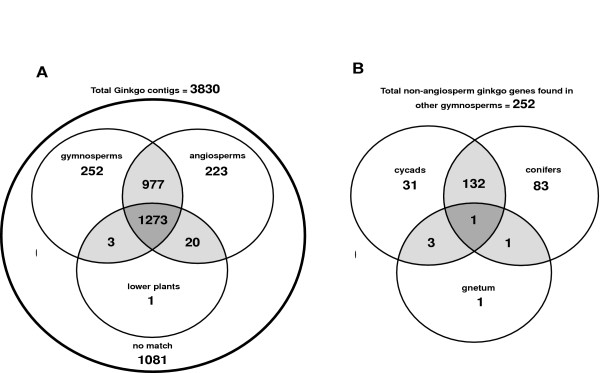
A Venn diagram illustrating the number of Ginkgo contigs with shared homology to genes found in non-seed plants, gymnosperms and/or angiosperms (A). A BLASTX E value >e 10-5 was used as a cut-off. (B) The Ginkgo contigs with similarity to gymnosperms but (no match to angiosperm genes) were further subgrouped according to their BLAST score homology (E value >e 10-5) within gymnosperm taxa.